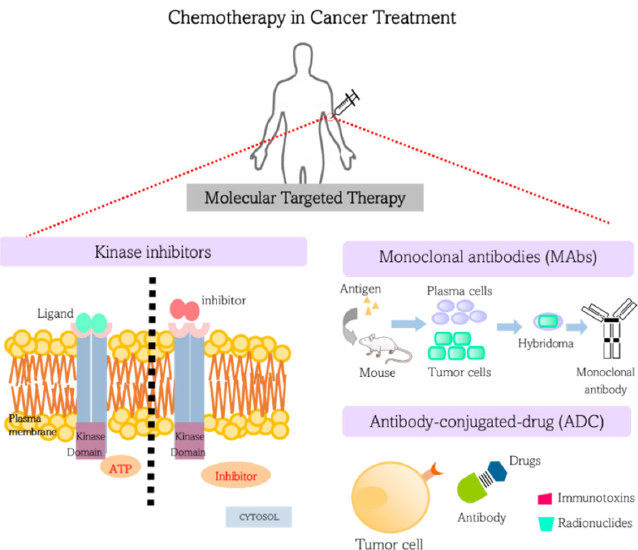
Figure 1. Different strategies of chemotherapy based on molecular target therapies.